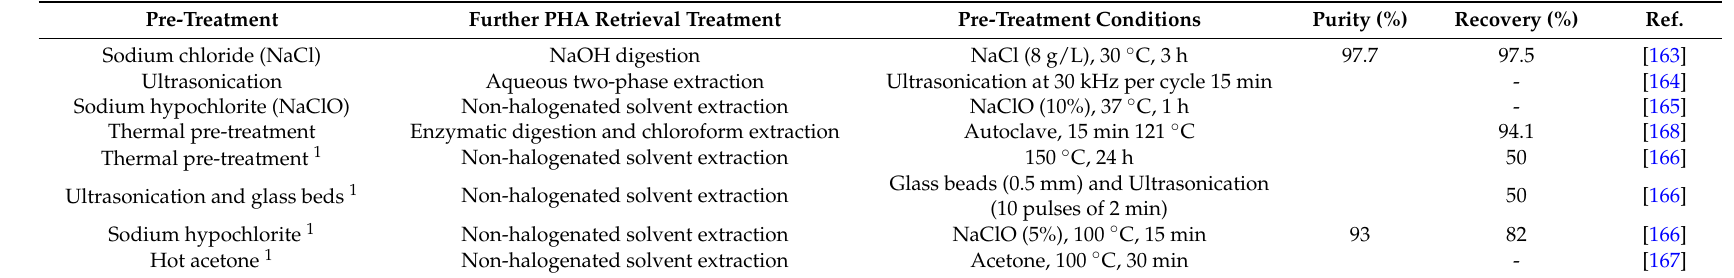
Table 5. Pre-treatment techniques applied for PHA